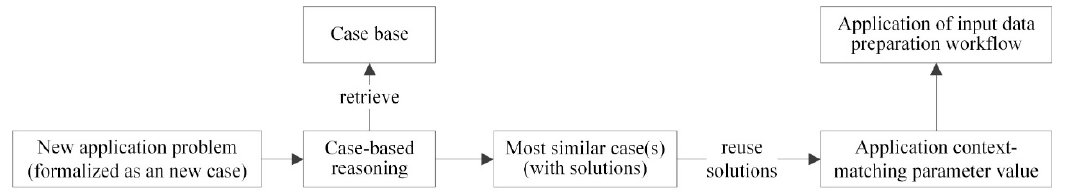
Figure 5. Case-based method for parameter settings of digital terrain analysis algorithm, revised from Qin et al. [34].